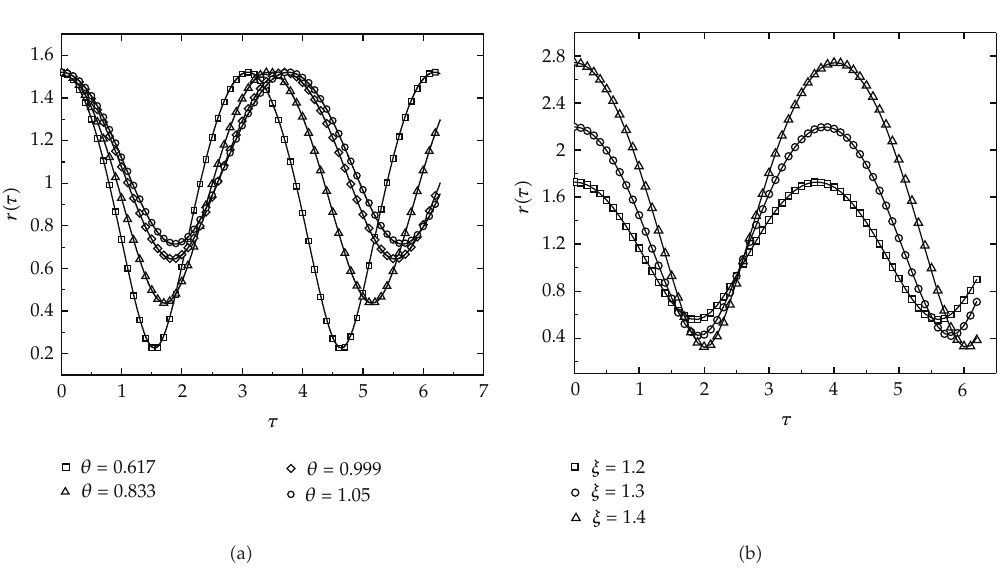
Figure 7: (cid:3) a (cid:4) Comparison between 5th-order HAM solution (cid:3) hollow symbols (cid:4) and Runge-Kutta numerical solution (cid:3) solid lines (cid:4) of r (cid:3) τ (cid:4) for di ff erent values of θ with the following fixed values: ξ (cid:9) 1 . 15, α (cid:9) 1, h (cid:9) − 2 . 3. Square symbols: Z (cid:9) 10 electrons, R c (cid:9) 125 ˚A and θ (cid:9) 0 . 617405; triangular symbols: for Z (cid:9) 100 electrons, R c (cid:9) 525 ˚A and θ (cid:9) 0 . 83334; diamond symbols: for Z (cid:9) 10 4 electrons, R c (cid:9) 1 . 064 μ m and θ (cid:9) 0 . 999939; circular symbol: for Z (cid:9) 10 8 electrons, R c (cid:9) 486 μ m and θ (cid:9) 1 . 05049. (cid:3) b (cid:4) E ff ect of varying the dimensionless initial radius ξ . Comparison between 5th-order HAM solution (cid:3) hollow symbols (cid:4) and Runge-Kutta numerical solution (cid:3) solid lines (cid:4) for r (cid:3) τ (cid:4) with: ξ (cid:9) 1 . 2 and h (cid:9) − 1 . 36 (cid:3) square symbols (cid:4) , ξ (cid:9) 1 . 3 and h (cid:9) − 1 . 25 (cid:3) circular symbols (cid:4) , ξ (cid:9) 1 . 4 and h (cid:9) − 0 . 97 (cid:3) triangular symbols (cid:4) . The remaining parameters are set to: α (cid:9) 1, θ (cid:9) 0 .